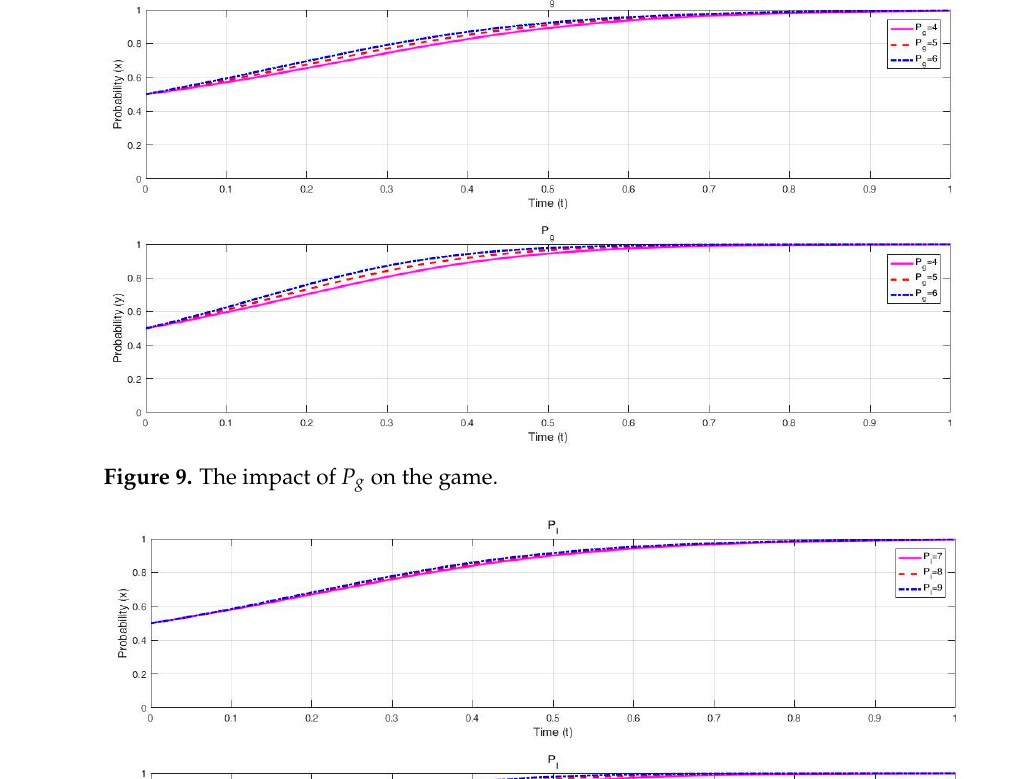
Figure 8. The impact of C l on the game.